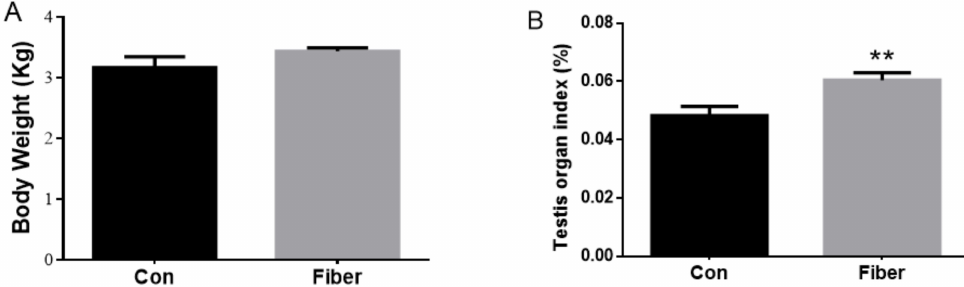
Figure 1. E ff ect of maternal fiber intake on the body weight ( A ) of o ff spring, ( B ) testis organ index of o ff spring. The values were expressed as mean ± SEM. ** p < 0.01, as compared to normal control group. Con = control group, Fiber = Fiber group.